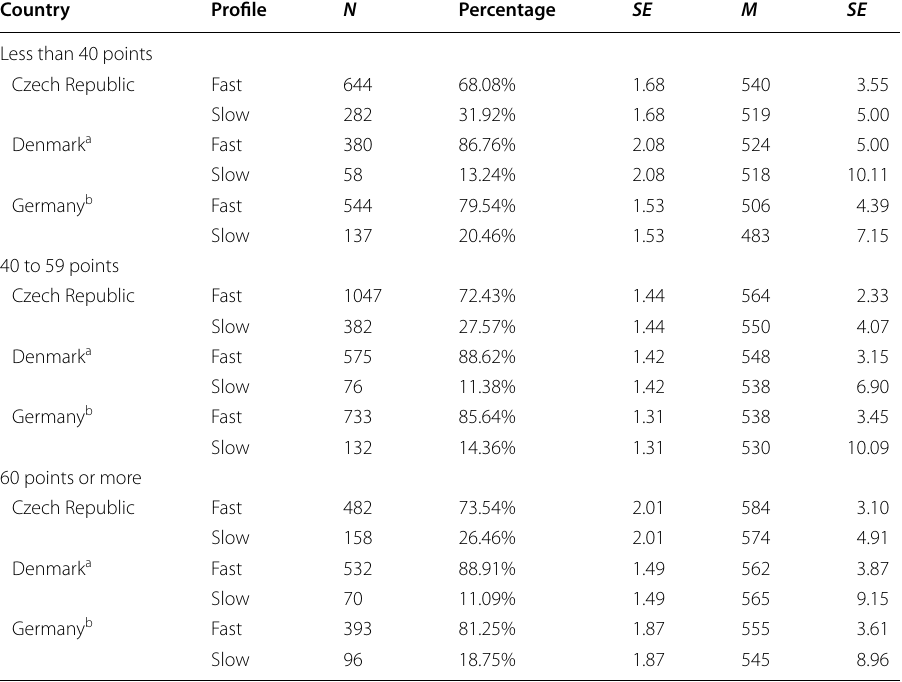
Table 6 Processing profiles, computer and information literacy (CIL) and